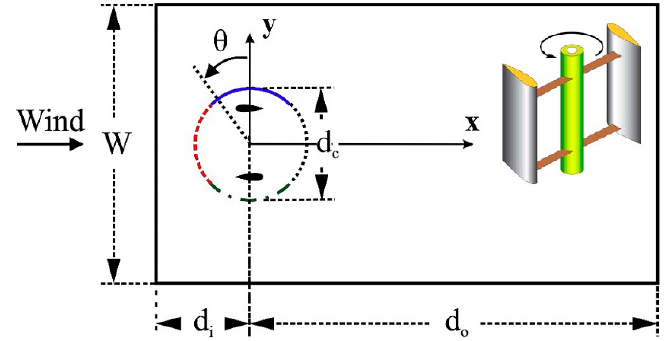
Figure 8. 2D Computational domain for the analysis of VAWT.